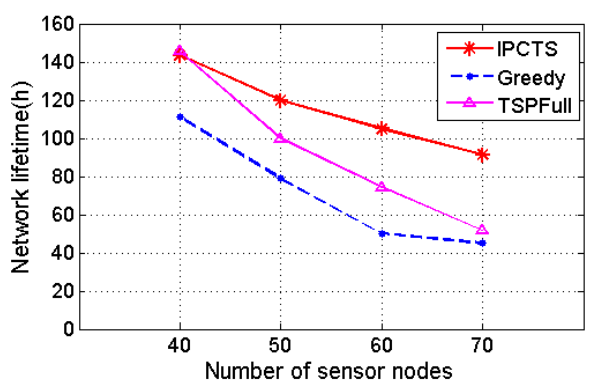
Figure 3. The effect of different charging times on the network lifetime.